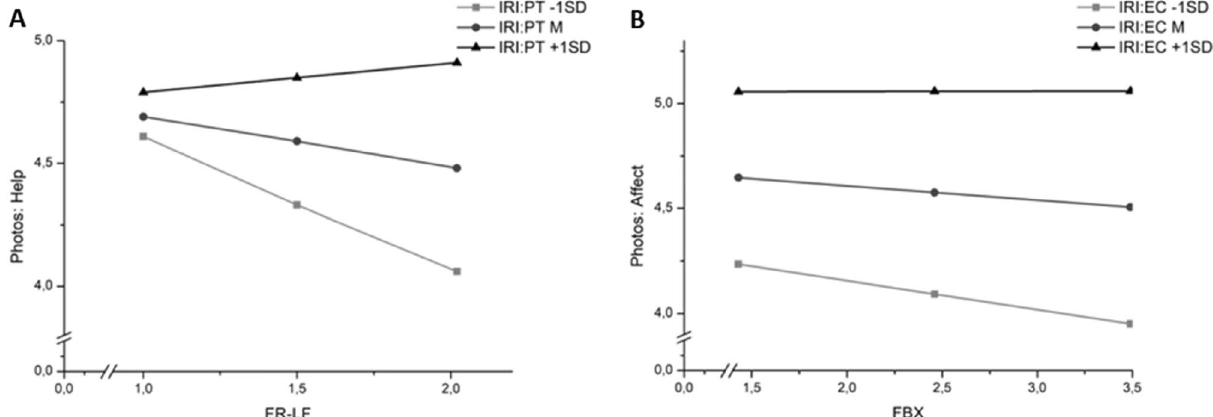
Figure 1. Moderation effects of trait empathy on the association between xenophobia and state empathy. ( A ) strongest moderation effect (p = .003; X = right-wing extremism (FR-LF), M = perspective taking (IRI: PT), Y = willingness to help). ( B ) weakest moderation effect (p = .103; X = fear-based xenophobia (FBX), M = empathic concern (IRI: EC), Y = negative affect in response to